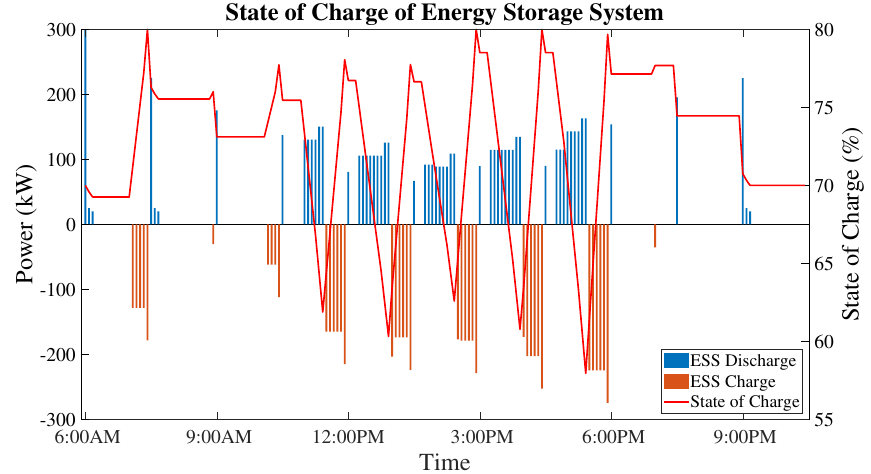
Figure 12. State of charge of energy storage system (case study 1).